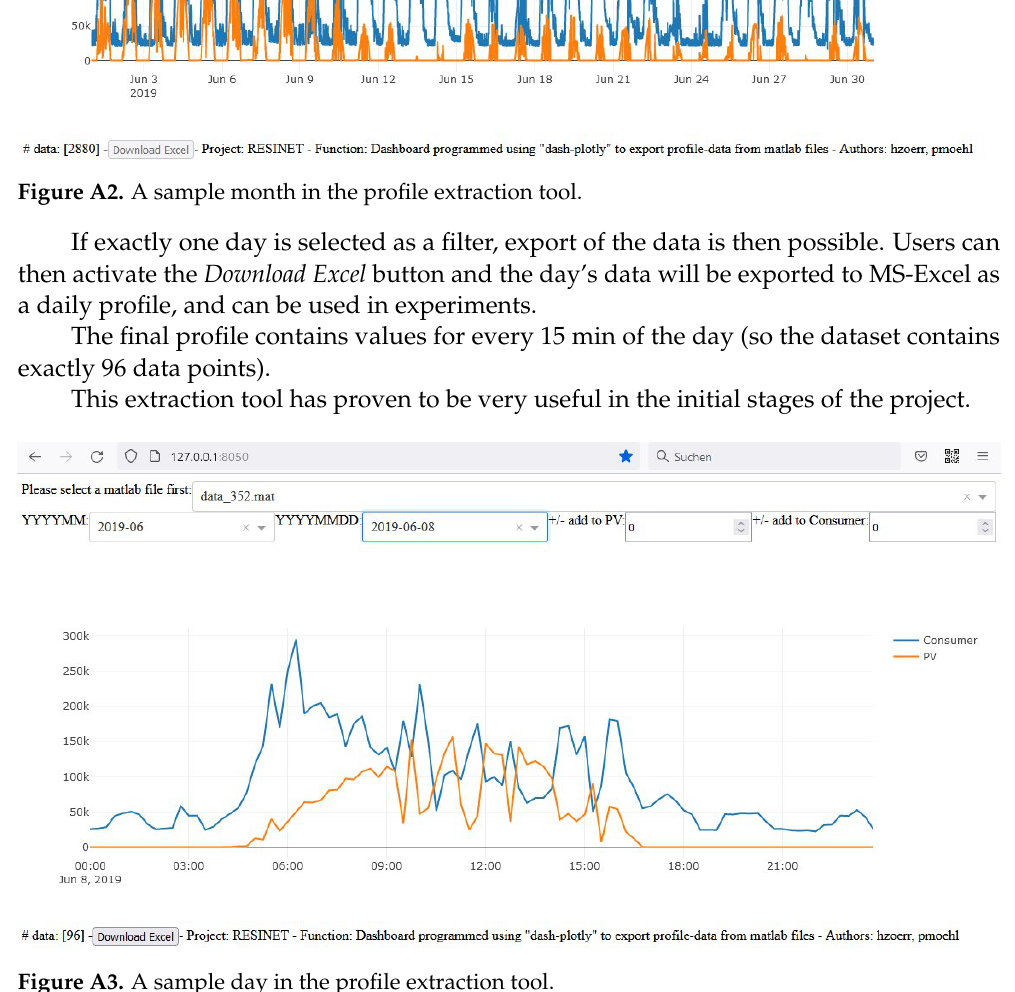
Figure A3. A sample day in the profile extraction